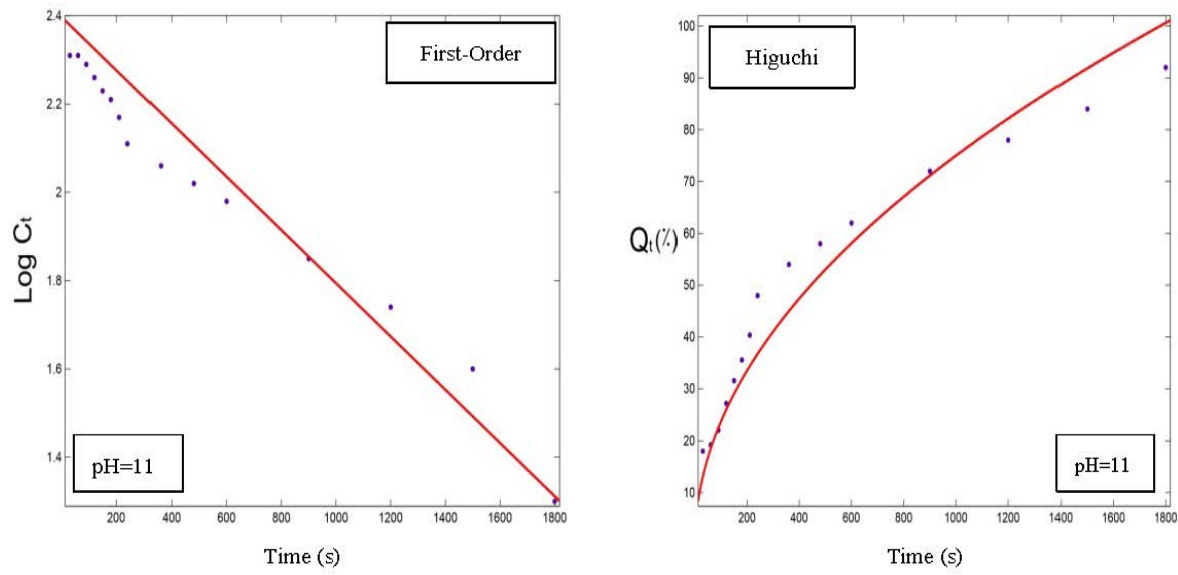
Figure 8. Release profiles (dots) and regression modeling (red lines) of orange peel oil dissolution from nano-delivery system of pectin–whey protein powder particles (NC3) at 90 °C.